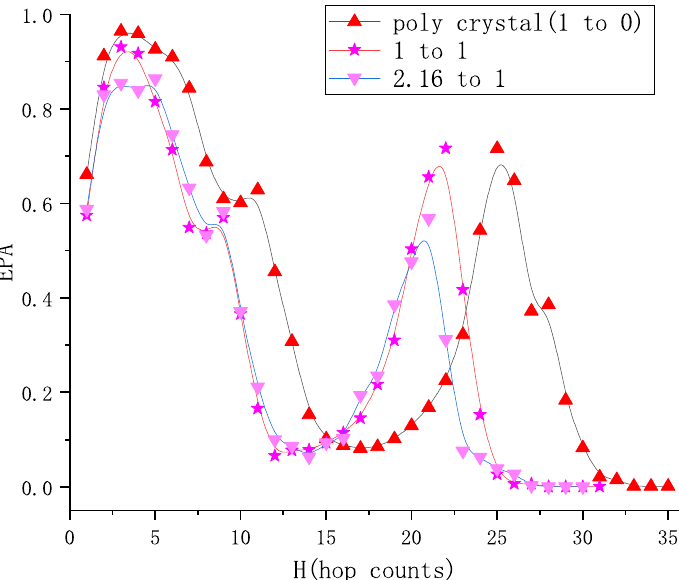
Figure 5. Effective prediction accuracy (EPA) versus hop counts (H). The number of anchor nodes in all systems is about 60% of the total number of